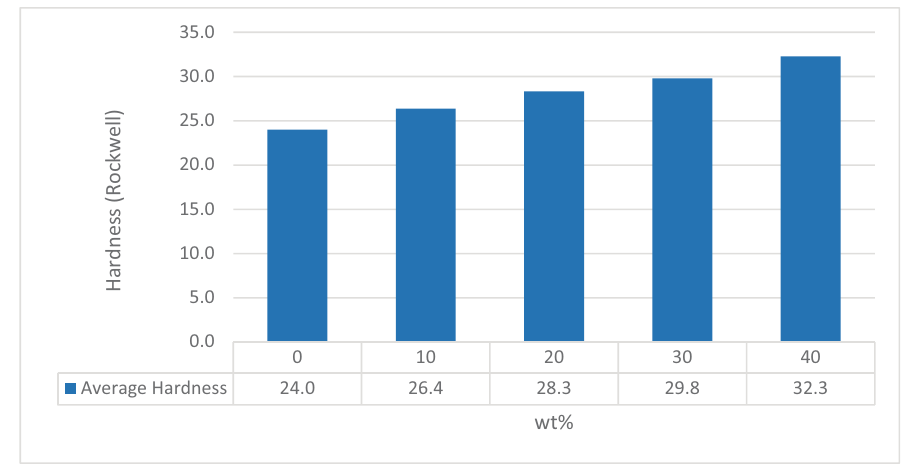
Figure 2: Rockwell values of PP composites at di ff erent wt% of coconut